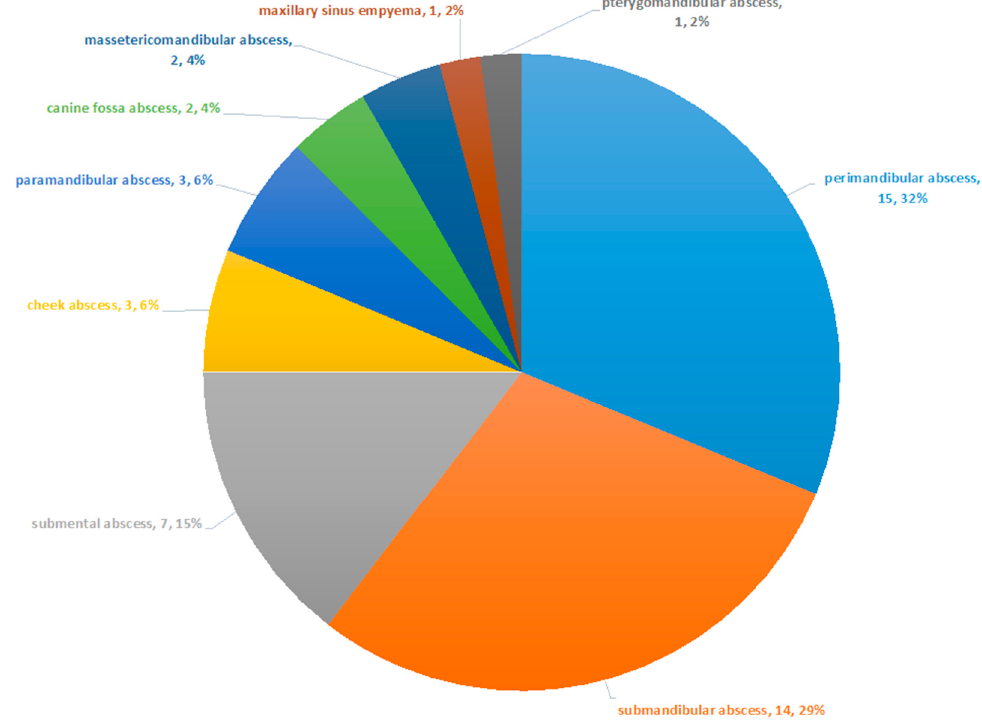
Figure 1. Frequency of observed abscesses. The most common abscesses were the perimandibular and the submandibular abscess.